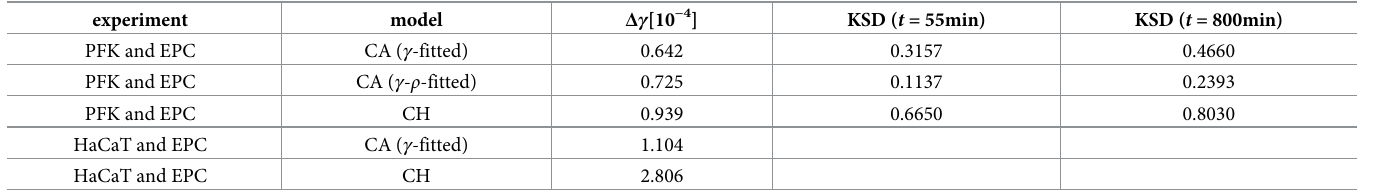
Table 1. Summary of the averaged mean squared deviation Δ γ and the Kolmogorow-Smirnow-Distance (KSD) between each model and the corresponding experi- ment, see Materials and methods for details.